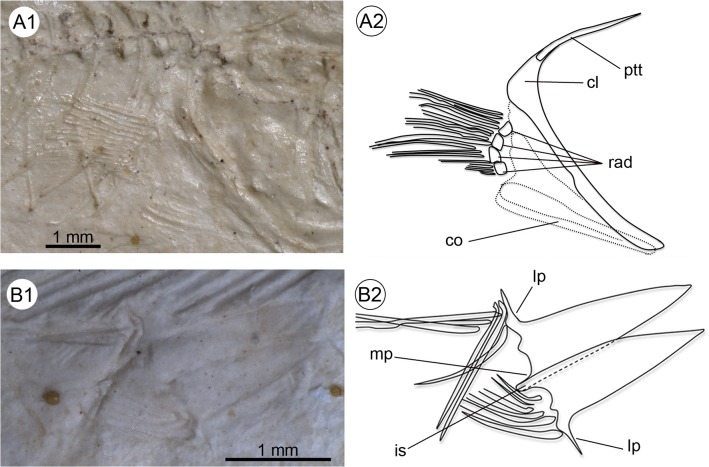
Details of the pectoral and pelvic girdles and fins seen in †Kenyaichthys kipkechi sp. nov., right lateral views.
A1–A2 Pectoral girdle and fin (paratype 1192´04); B1–B2 Pelvic girdle and fin (paratype 1218a´05). Abbreviations: cl, cleithrum; co, coracoid; is, ischial process; lp, lateral process; mp, medial process; ptt, posttemporal; rad, pectoral radials.